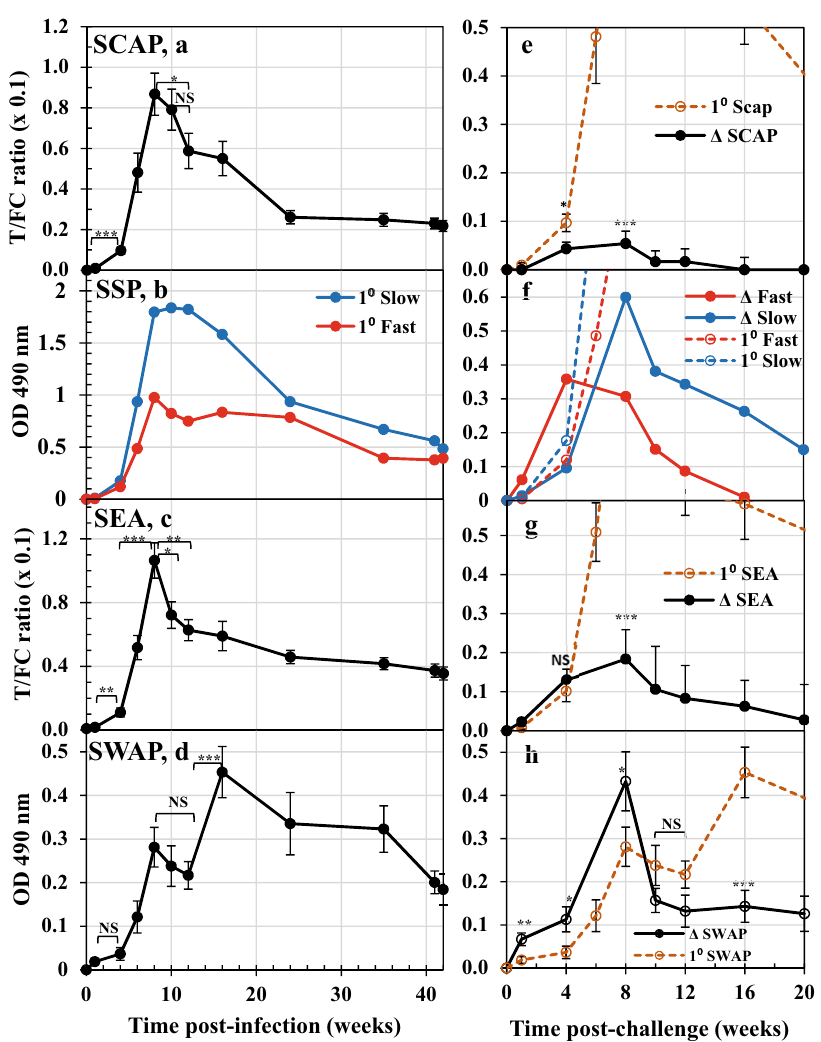
Fig. 5 Probing antibody responses. Responses detected over the time course of the primary infection (weeks post-infection) with soluble antigen preparations extracted from: a cercariae (soluble cercarial antigen preparation, SCAP); b cultured schistosomula (soluble schistosomula protein, SSP); c eggs (soluble egg antigen, SEA); d adult worms (soluble antigen preparation of adult schistosomes, SWAP). Values for SCAP, SEA and SWAP are means ± SE, n = 11 rhesus macaques, excluding Rh10. Statistical comparisons made using one-sided Student ’ s t -test are indicated with brackets, and signi fi cance P < 0.05 *, <0.01**, <0.001***. Those for SSP are responses detected by pools of four Fast (red) and four Slow (blue) responder animals at each time point, without replication due to the low protein yield of the SSP preparation. n = 4 macaques from the Slow and 4 from the Fast groups. e – h Responses detected over the 20 weeks post-challenge using the same four antigen preparations are plotted in: e SCAP; f SSP; g SEA; h SWAP. The antibody reactivity detected is shown as the change observed ( Δ ), relative to the Week 42 values so that anamnestic responses can be evaluated statistically against the primary responses; data from Weeks 0 to 20 post-infection are replotted as dashed lines for comparison. Values are means ± SE, n = 11 rhesus macaques (excluding Rh10), except for SSP, as above. Statistical comparisons were made using a one-sided Student ’ s t -test between the primary and secondary means at the selected time points indicated, with signi fi cance P < 0.05 *, <0.01**, <0.001***. NS not signi fi cant. Source data are provided as a Source Data fi